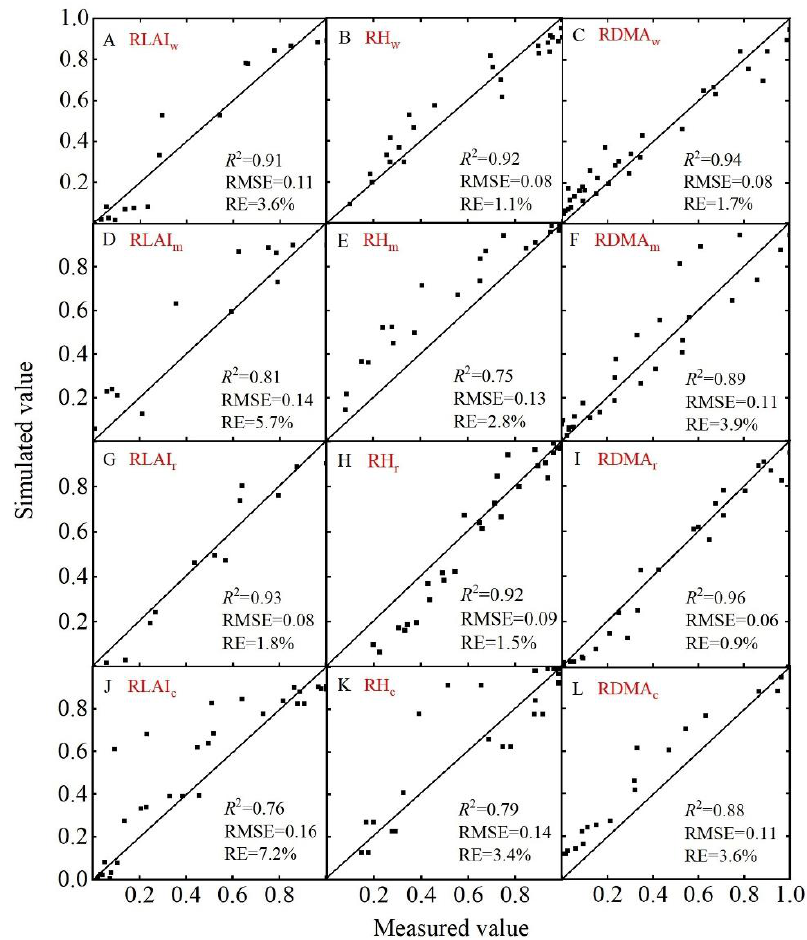
Figure 8. Validation diagram of the comprehensive and fully relative logistic growth model. RLAI w , RLAI m , RLAI r , and RLAI c represent the leaf area indexes for winter wheat ( A ), summer maize ( D ), rice ( G ), and cotton ( J ), respectively. RH w , RH m , RH r , and RH c represent plant heights for winter wheat ( B ), summer maize ( E ), rice ( H ), and cotton ( K ), respectively. RDMA w , RDMA m , RDMA r , and RDMA c represent the accumulations of dry matter for winter wheat ( C ), summer maize ( F ), rice ( I ), and cotton ( L ), respectively.